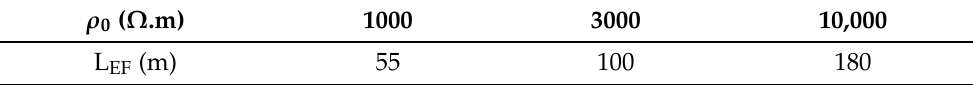
Table 2. Effective length of the counterpoise wires for first negative strokes.